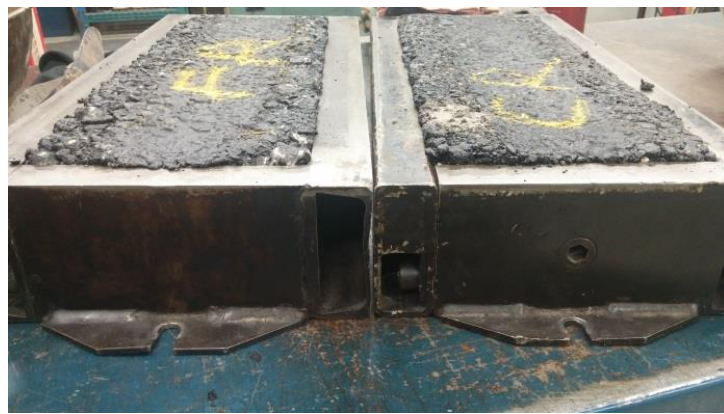
Figure 13. Permanent deformation result.